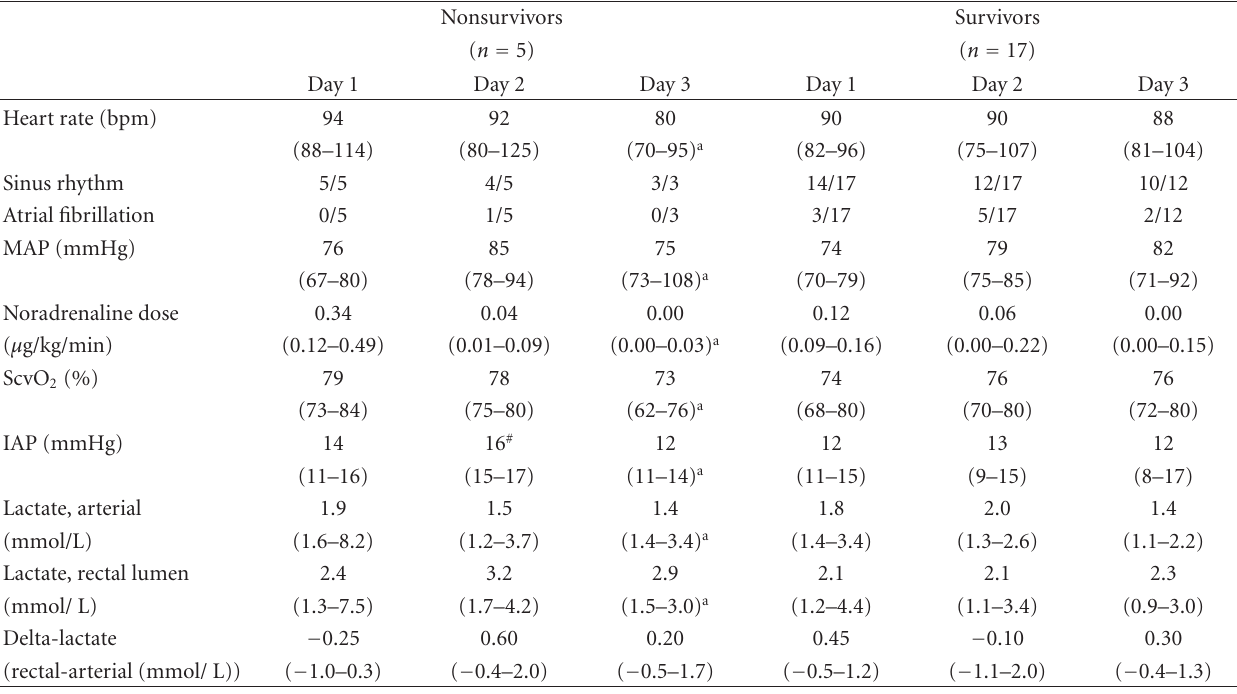
Table 2: Daily parameters in 22 patients with septic shock stratified by survival.